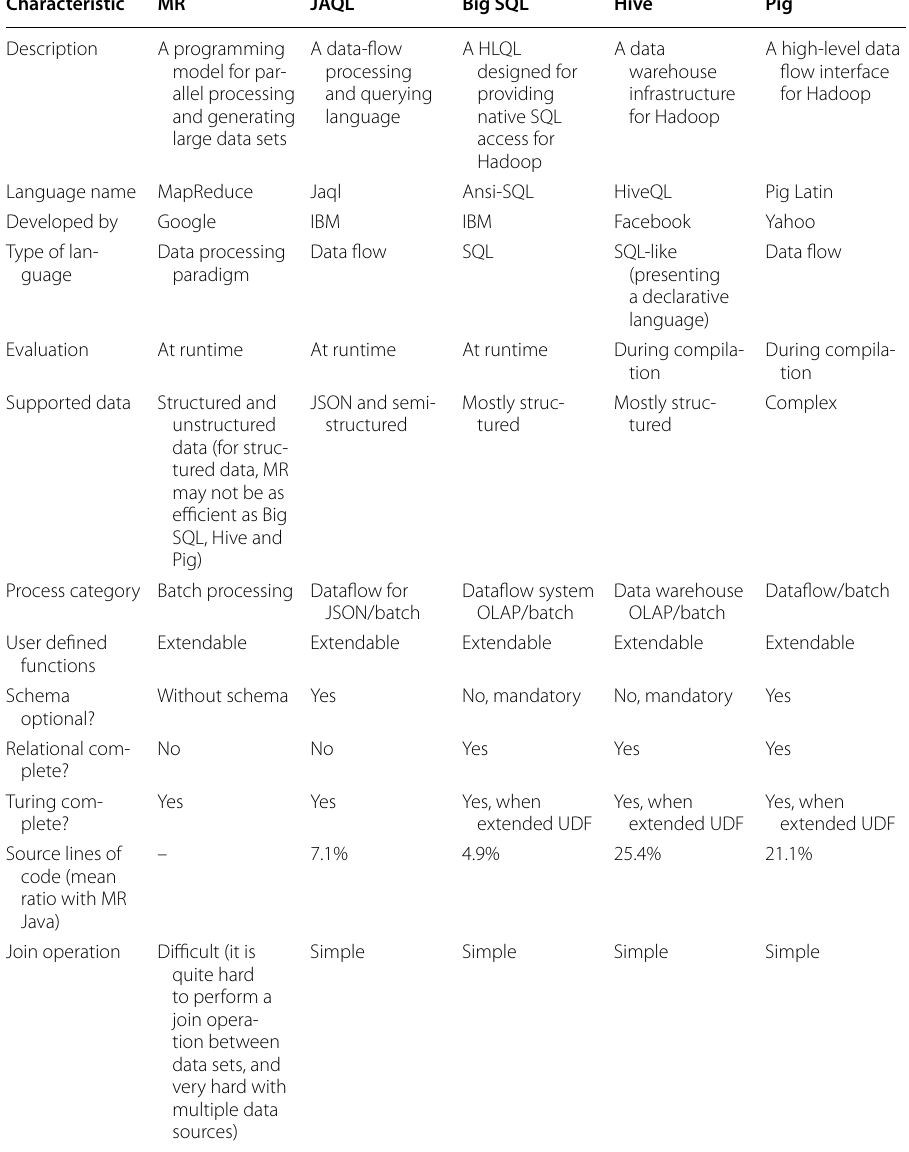
Table 1 Comparative study between Big SQL, Pig, Hive and JAQL Characteristic MR JAQL Big SQL Hive